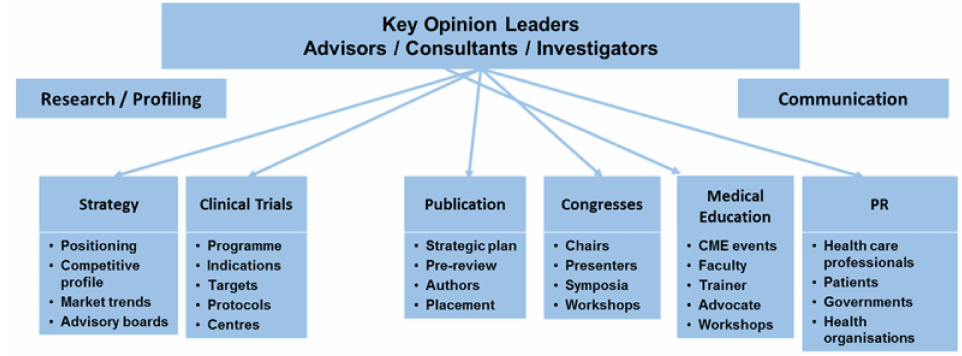
Figure 2. Interactions between HCPs/HCOs and pharmaceutical companies during a drug’s life